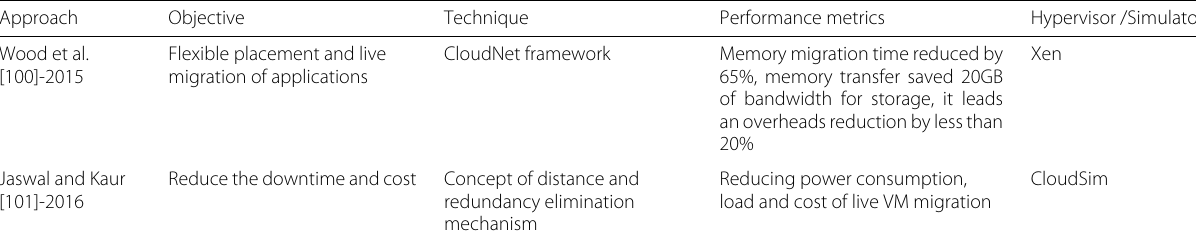
Table 8 Comparison of Redundancy based VM migration approaches